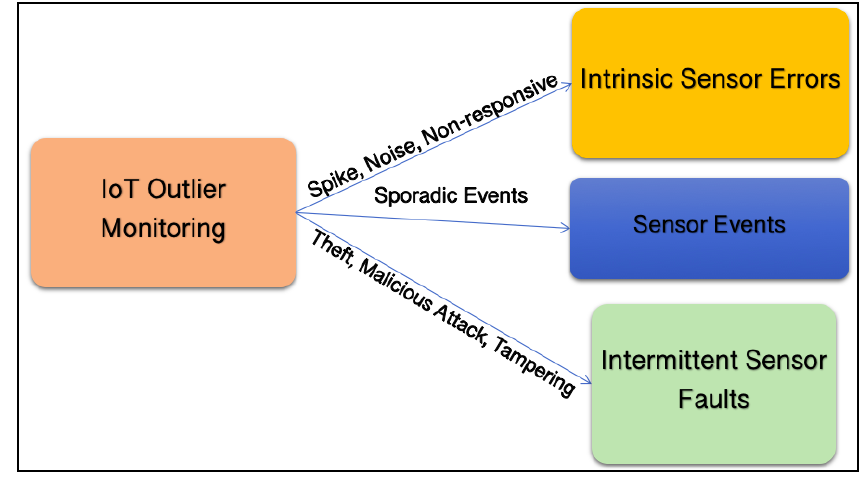
Figure 4. Sensor outlier sources in